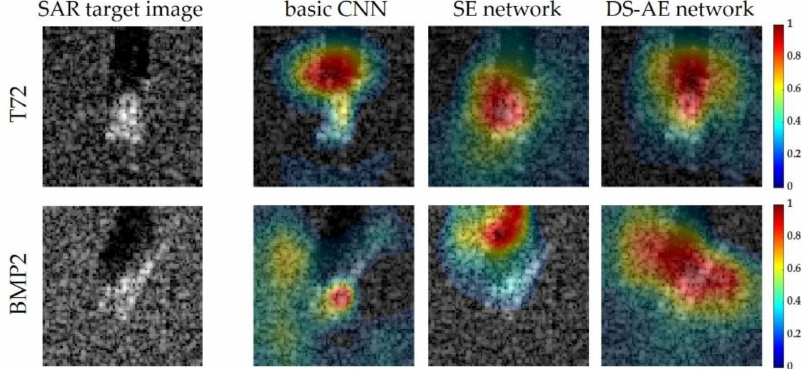
Figure 6. SAR target images and class activation maps of T72 (1st row) and BMP2 (2nd